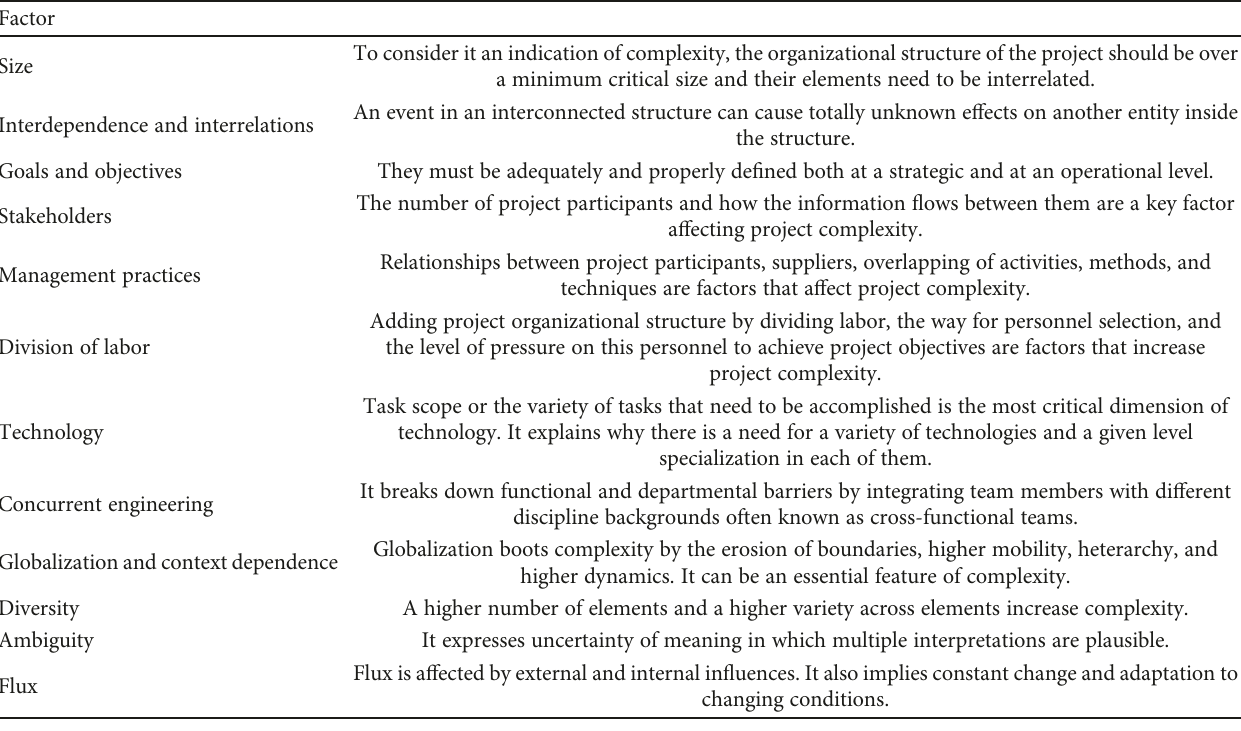
Table 1: Main factors a ff ecting project